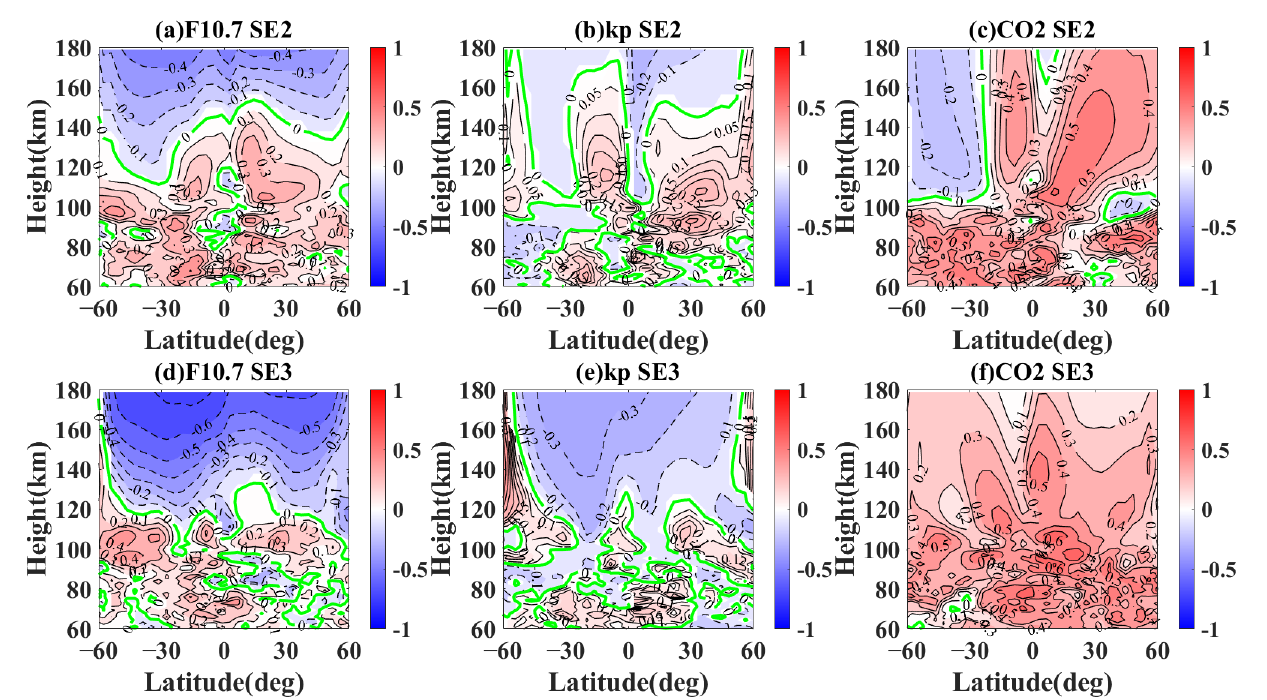
Figure 9. The correlation between non-migrating tidal variations ( a – c ) SE2, ( d – f ) SE3, and ( a , d ) F10.7 cm index, ( b , e ) kp index, and ( c , f ) CO 2 between 60 ° S and 60 ° N from 2003 to 2019. The green curve means the zero lines.